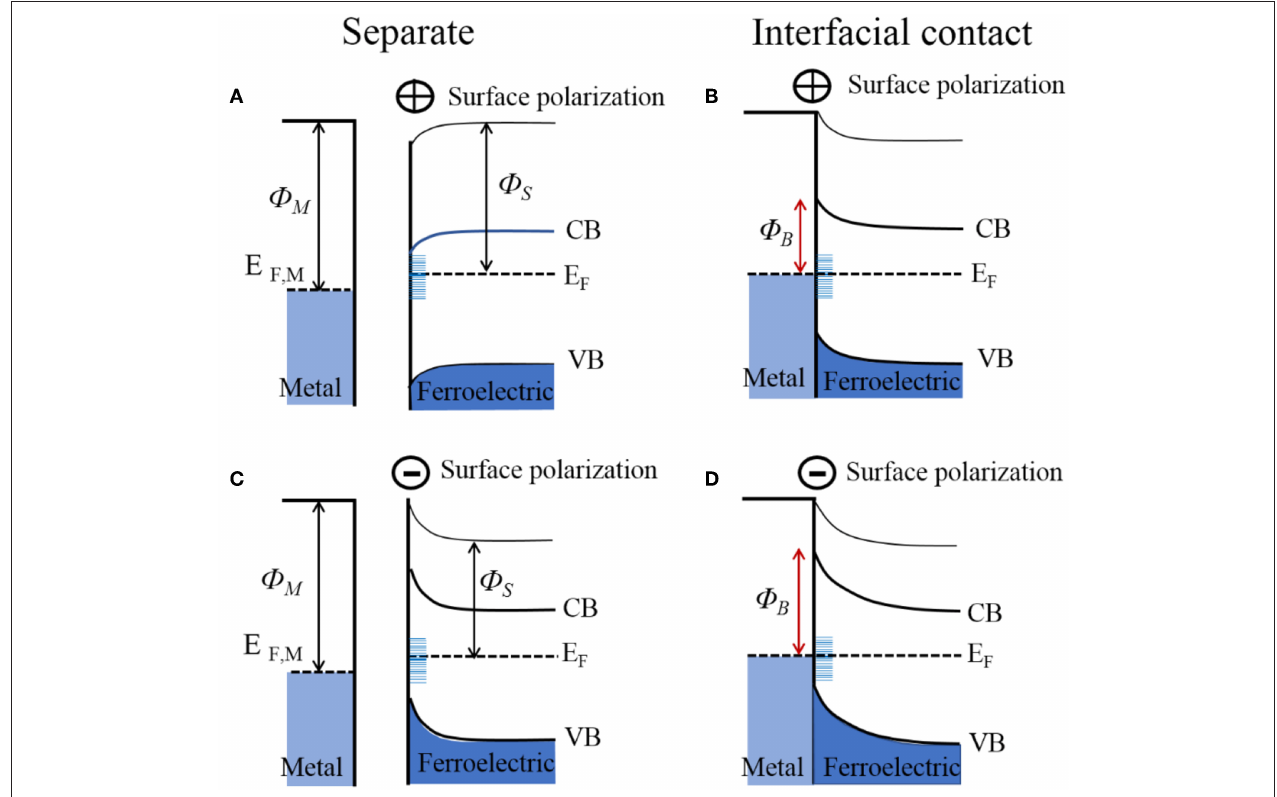
FIGURE 6 | Electronic energy levels of an n -type ferroelectric for its surfaces that are positively charged (upper; A,B ) and negatively charged (lower; C,D ), shown before and after interfacial contact with a metal. Φ M , metal work function; Φ S , semiconductor work function; Φ B , Schottky barrier height; E F , Fermi level; CB, conduction band; VB, valence